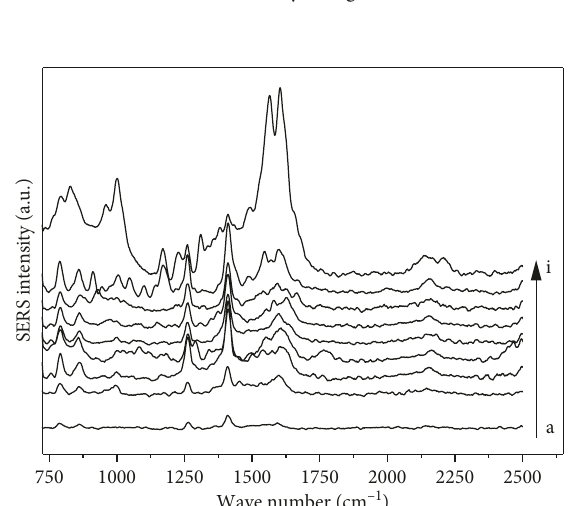
Figure 6: Stability of light